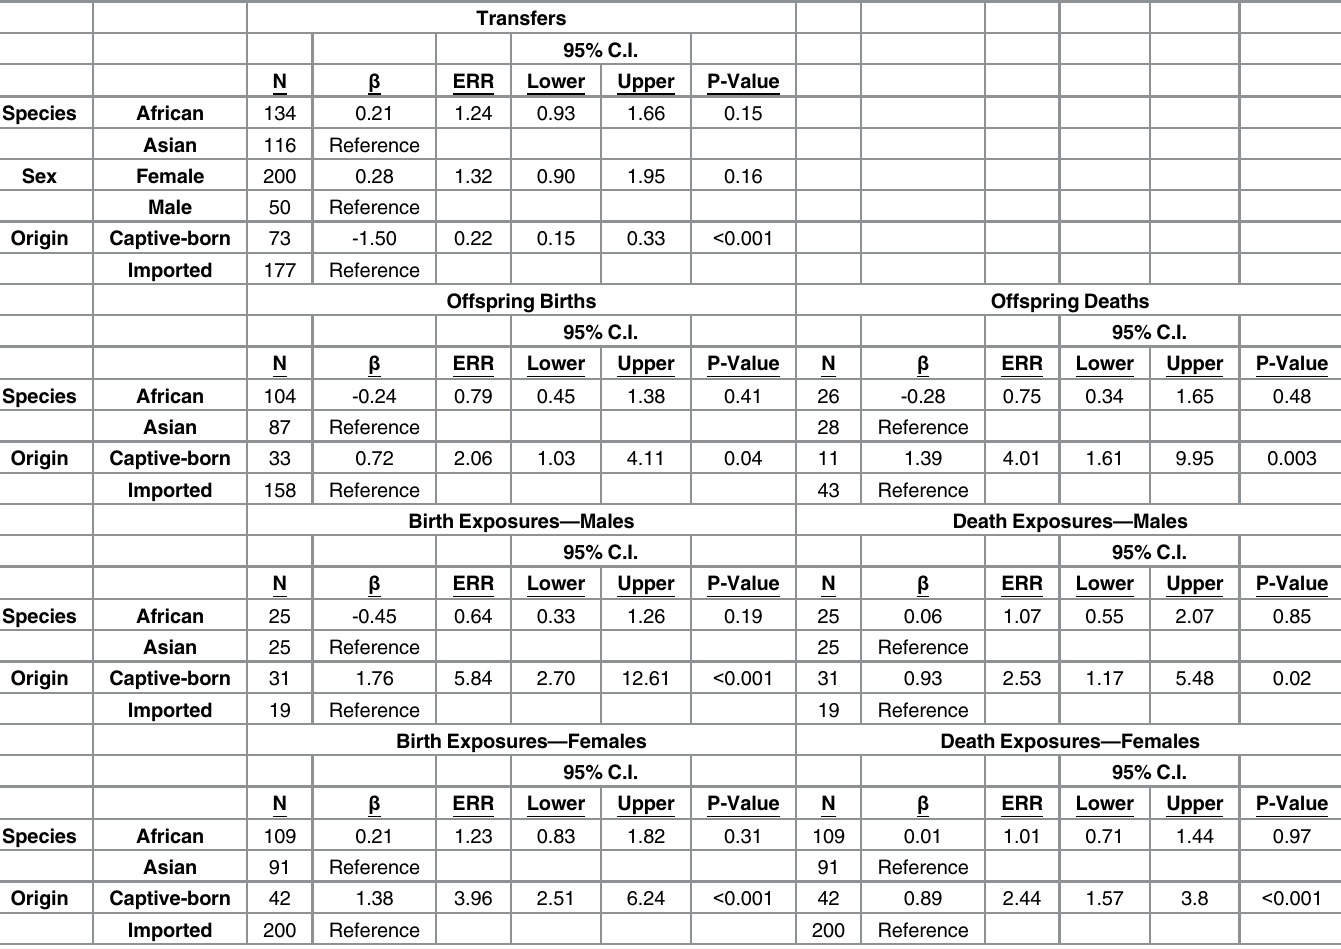
Table 8. Summary of parameter estimates for estimated relative risk (ERR) of exposure to/experiencing the first recorded event using multi-vari- able Cox regressions, including 95% Wald confidence intervals for ERR. p < 0.05. ERR = estimated relative risk of exposure to/experiencing the first